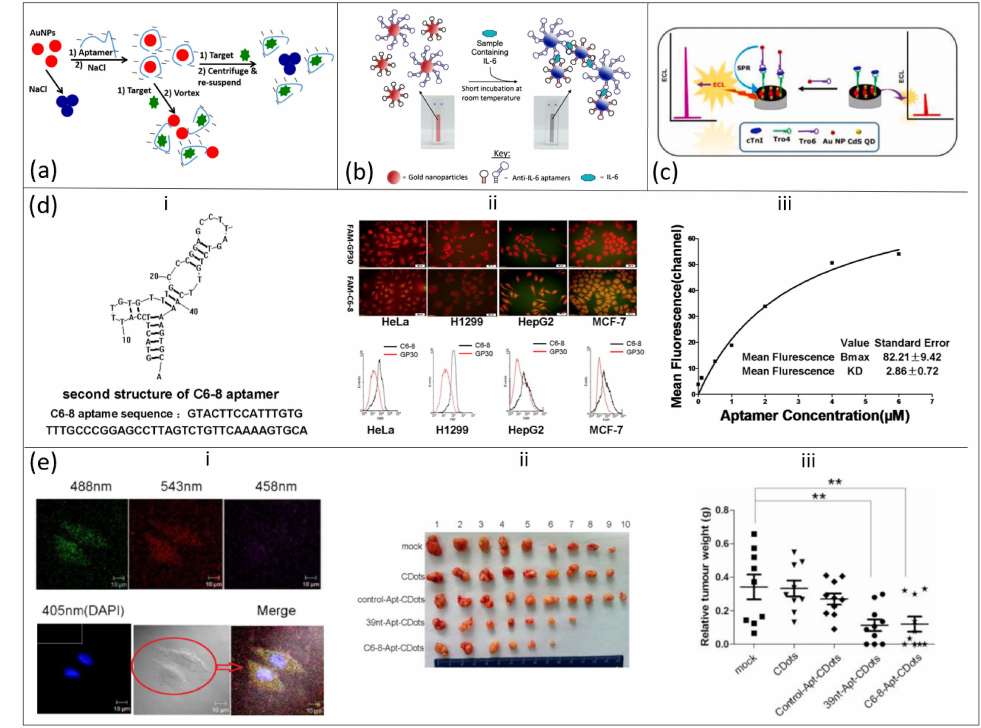
Figure 2. Application of aptamer-gold nanoparticles (AuNPs)/quantum dots (QDs)/carbon nan- odots(CDs) conjugates in medical diagnosis. ( a ) Schematic representation of AuNPs function in a colorimetric aptasensor. This image was adapted from Alsager et al. [36] with permission from Nature . ( b ) Detection of interleukin-6 using a colorimetric aptasensor. Aptamers with two compli- mentary IL-6 target moieties were coated on AuNPs and exposed to protein mixtures containing IL-6. Aggregation of AuNPs, vis-a-vis color changes, occurred via Van der Waal binding of IL-6 with the aptamers sandwiched with the two complimentary IL-6 moieties. This image was adapted from Giorgi-Coll et al. [37] with permission from Springer Nature. ( c ) Schematic representation of an electrochemiluminescence (ECL) aptasensor based on conjugation of CdS QDs and cardiac troponin aptamer (Tro6). This image was adapted from Kitte et al. [40] with permission from Elsevier. ( d - i ) The sequence and secondary structure of C6-8 aptamer isolated using the Cell SELEX procedure. ( d - ii ) Selection of C6-8 aptamer based on its affinity for multiple tumor cell lines as revealed by fluorescence micrographs. Below: flow cytometry analysis revealing specific binding preference of C6-8 aptamer to HepG2, MCF-7, H1299, and HeLa tumor cells. Inset: ( d - iii ) The binding affinity, as measured by fluorescence microscopy, of aptamer to representative HeLa cell. ( e - i ) Confocal micrograph of showing the CDs–C6-8 aptamer’s ability to inhibit proliferation of lung cancer cells, hepatocarcinoma (GFP-HepG2), at each point time. Reprinted with permission from Elsevier